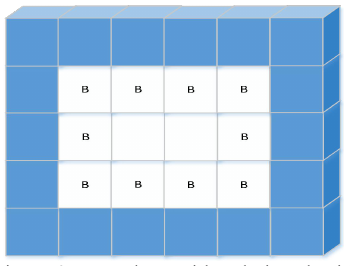
Figure 3. Boundary grid and virtual grid